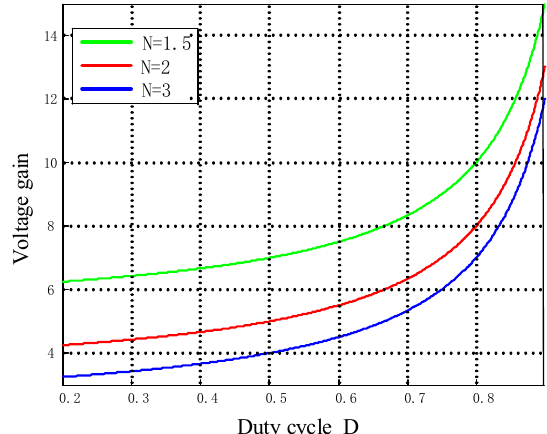
Figure 5. Effect of N on voltage gain.